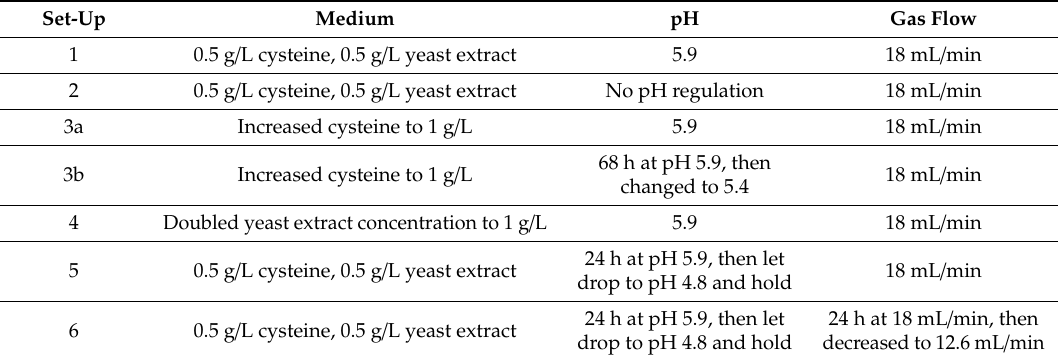
Table 1. Experimental setup. All fermentations were done as triplicates ( n = 3), except for Setup 3, where one fermenter was kept unaltered (Setup 3a) and two fermenters were treated (Setup 3b).